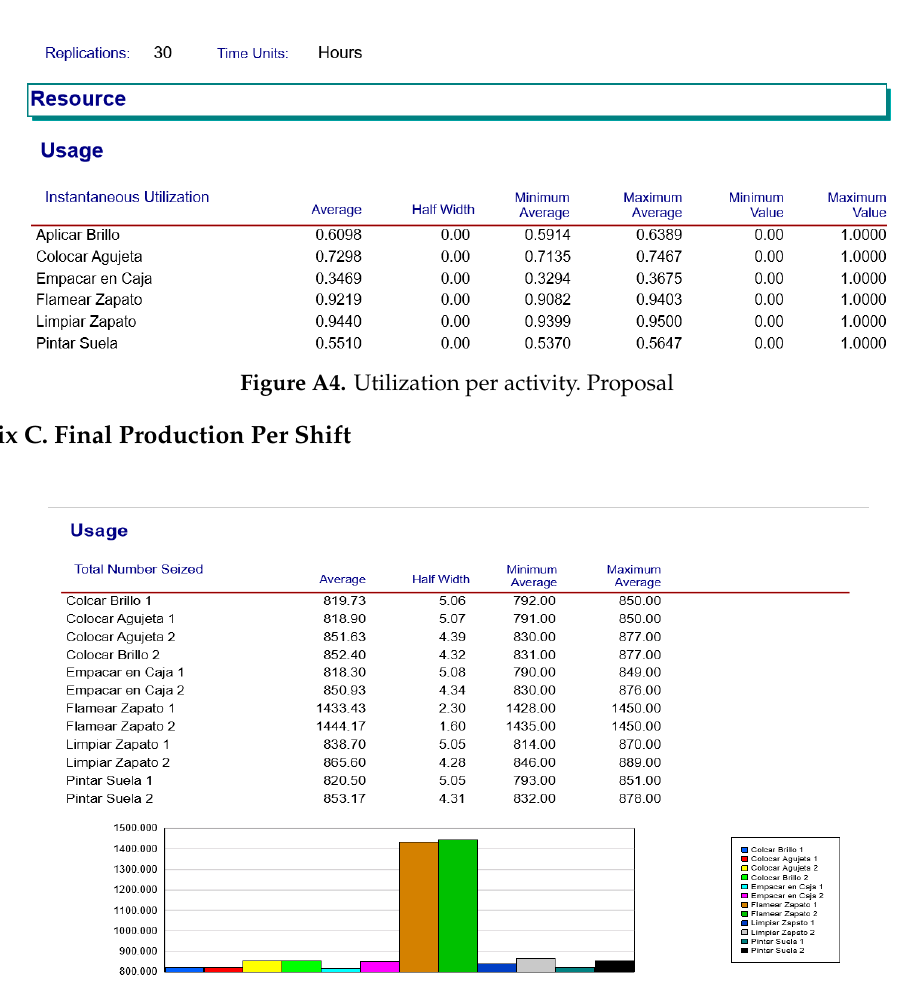
Figure A3 . Utilization per activity. Current process.